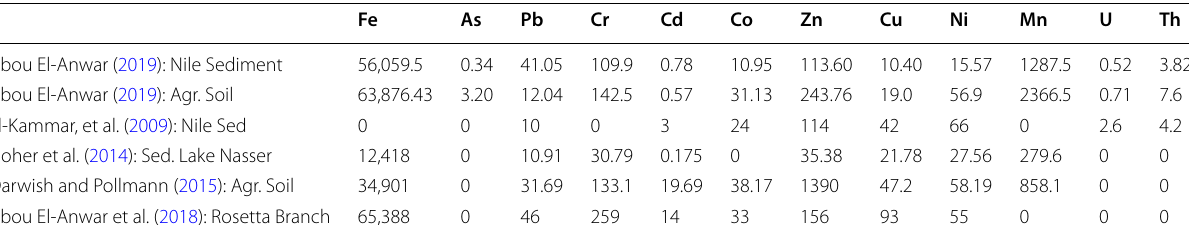
Table 4 The concentration of the elements in study area with others localities (ppm)